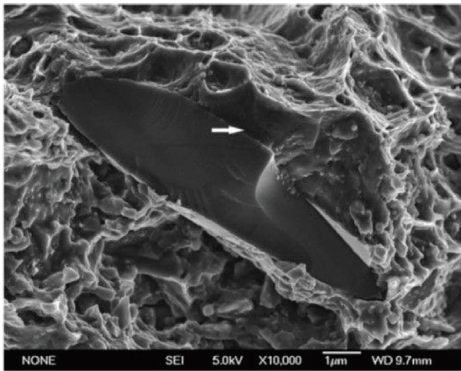
Figure 7: SEM micrographs of the nucleation of cracks result from the breaking of SiC particles